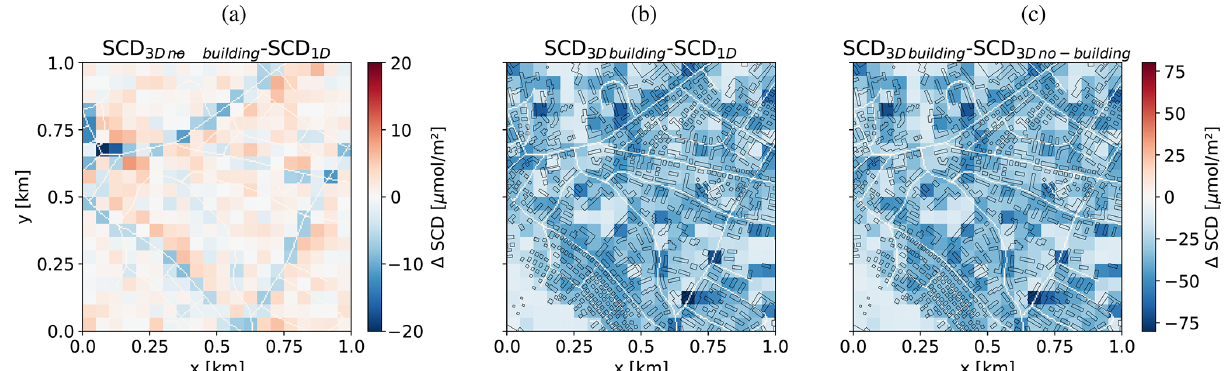
Figure 7. (a) Difference plot between SCDs calculates with 3D-box AMFs and the SCDs calculated with 1D-layer AMFs. (b) Difference plot between SCDs calculated with 3D-box AMFs including the urban canopy and SCDs calculated with 1D-layer AMFs. (c) Difference plot between SCDs calculated with 3D-box AMFs with and without including the urban canopy.